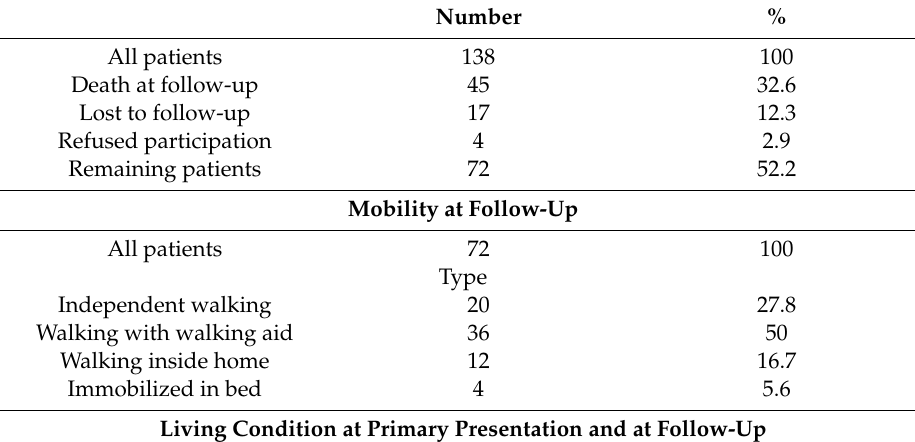
Table 5. Mortality, mobility and living condition before trauma and at